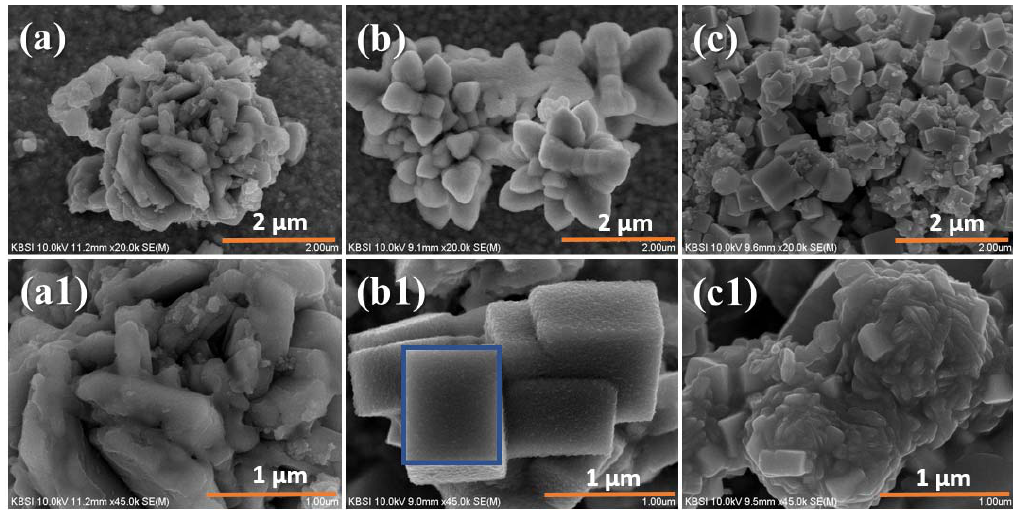
Figure 1. ( a – c ) Low and high ( a1 – c1 ) resolution FE-SEM images of the prepared CuS, PbS and CuS@PbS composite.